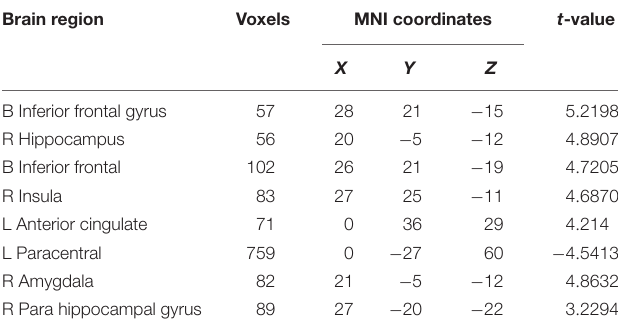
TABLE 4 | Brain regions where the ALFF differed between the FG and CG. Brain region